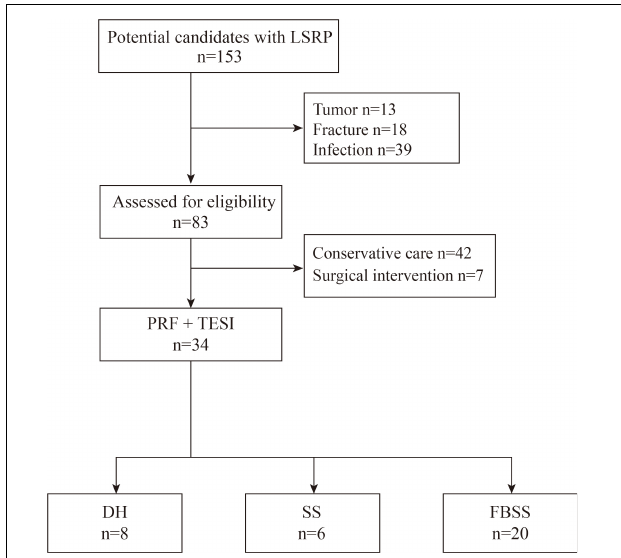
FIGURE 1 | Flow chart of patient